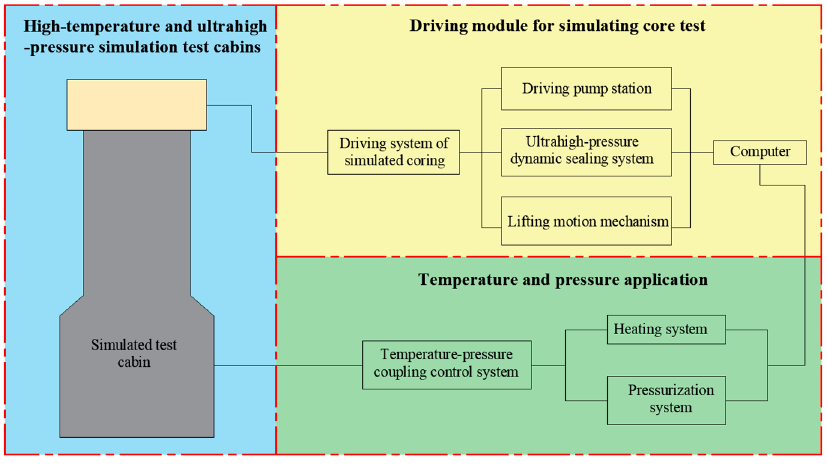
Figure 1. Schematic diagram of the in-situ simulation